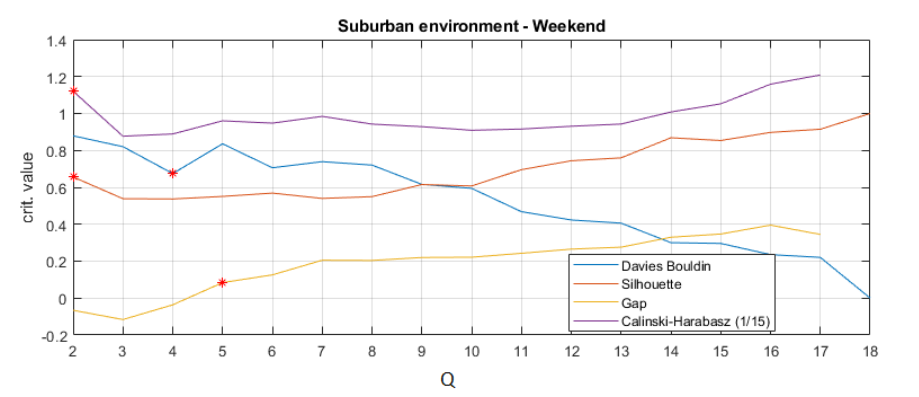
Figure 8. Clustering validity indices obtained for the acoustic suburban environment at the weekend, resulting from the agglomerative hierarchical clustering algorithm for the considered number of clusters sweep 2 ≤ Q ≤ 18. The suboptimal number of clusters are marked as red asterisks, being the local maxima in all clustering indices despite the Davies–Bouldin index, which is a local